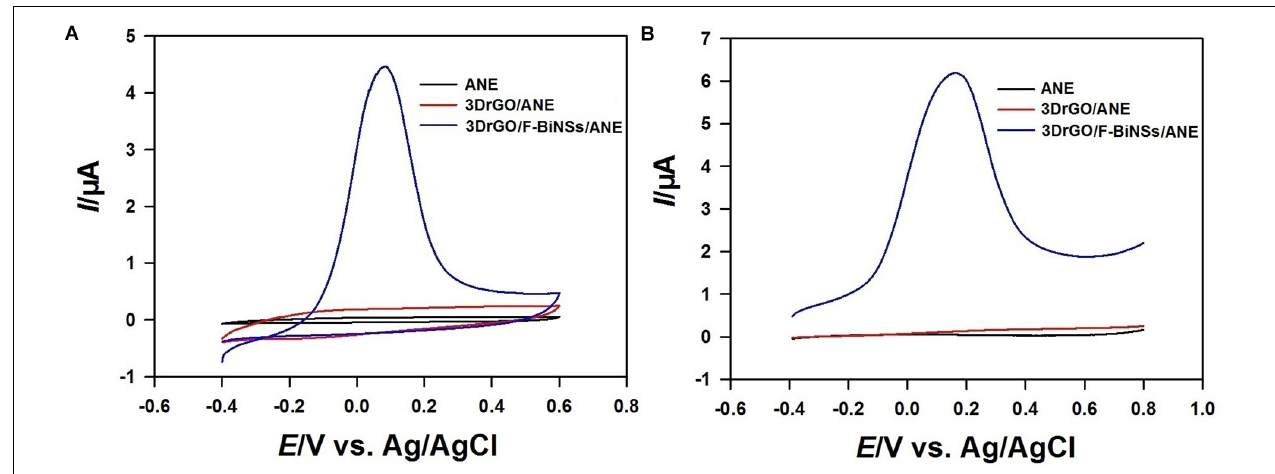
Frontiers in Marine Science |